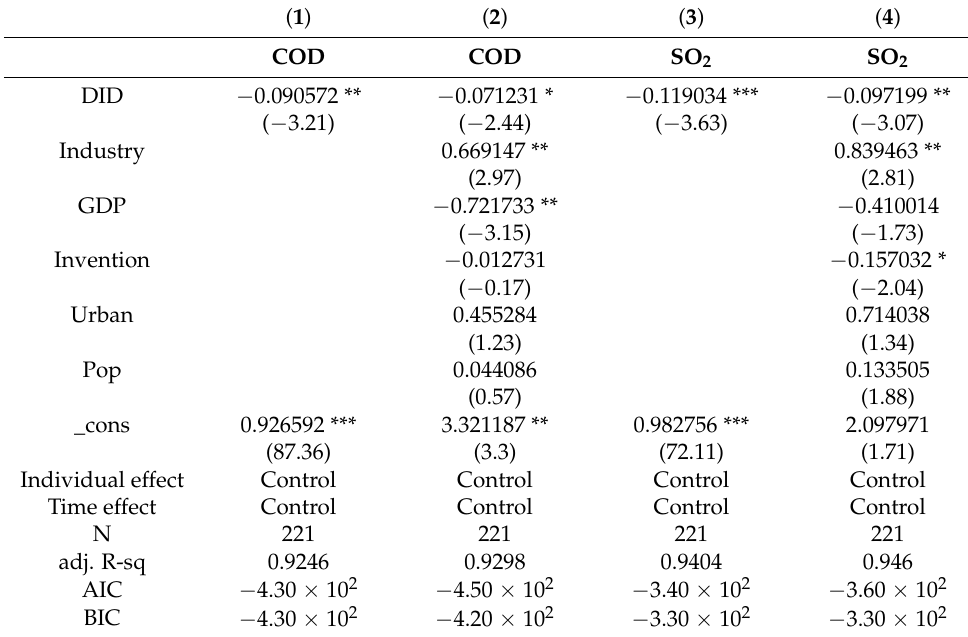
Table 5. Treatment effect: Year-by-year PSM-DID